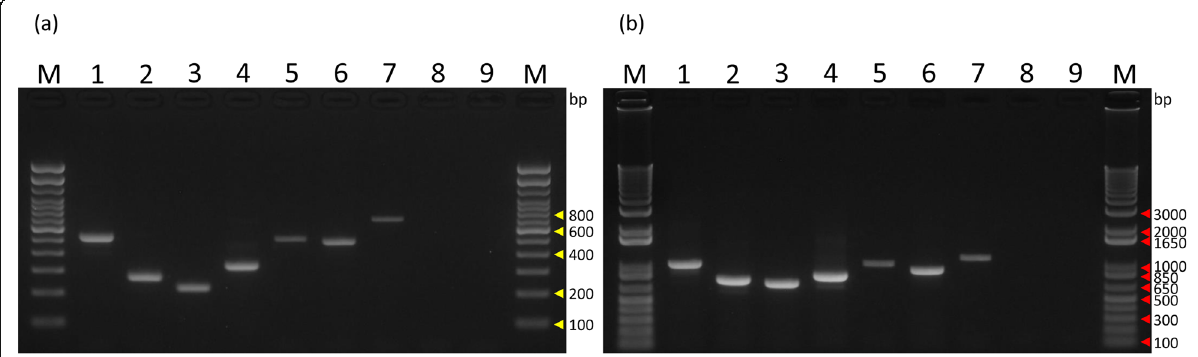
Fig. 2 Specificity of multiplex primers to each fusion gene. Multiplex PCR for EWSR1/FUS-ETS transcript variants using Set A (a) and Set B (b) primers. Lane M: Trackit 100-bp ladder marker (a) or Trackit 1-kbp plus ladder (b). Molecular sizes are indicated in the right with yellow arrowheads (a) and red arrowheads (b), respectively.; lane 1: NCR-EW2 cDNA ( EWSR1-FLI1 ); lane 2: WES cDNA ( EWSR1-ERG ); lane 3: EWSR1-ETV1 plasmid; lane 4: NCR-EW3 cDNA ( EWSR1-ETV4 ); lane 5: EWSR1-FEV plasmid; lane 6: FUS-ERG plasmid; lane 7: FUS-FEV plasmid; lane 8: HEK293 cDNA; lane 9: no template control. The plasmid samples contained the same amount of HEK293 cDNA as the Ewing cell lines